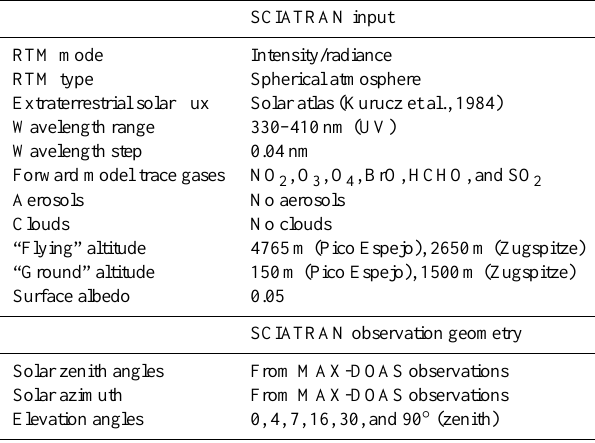
Table 1. Parameter settings used for the computation of synthetic spectra with the radiative transfer model